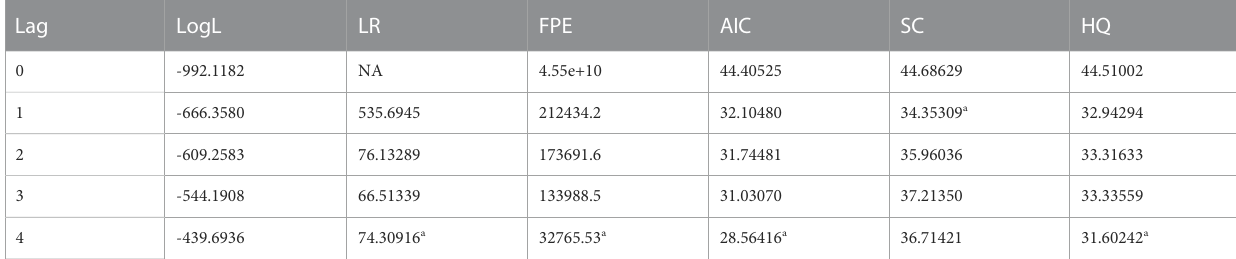
TABLE 5 Lag length